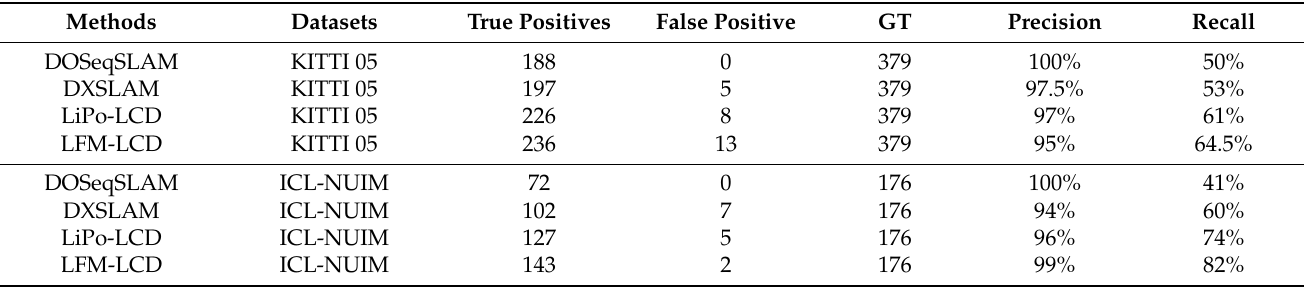
Table 7. Comparative